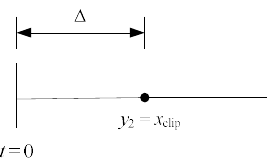
Figure 3. Illustration of binary quantizer type 2.